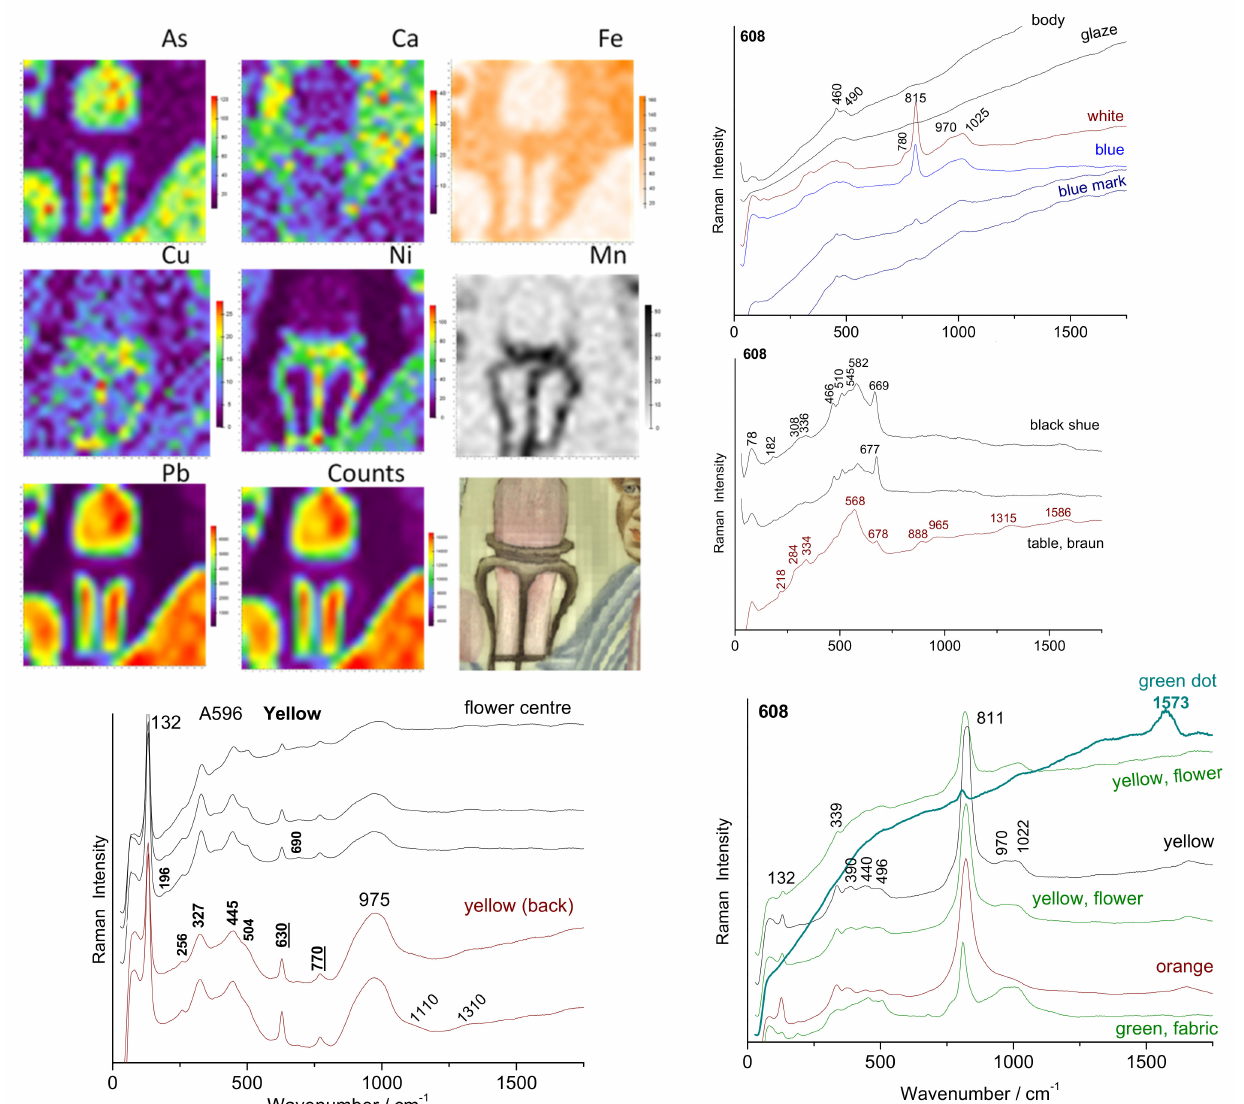
Figure 11. Comparison of representative Raman spectra for the different colored areas of two dishes (A596 and A608). XRF mapping of A608 center area for different elements showing the variation in their